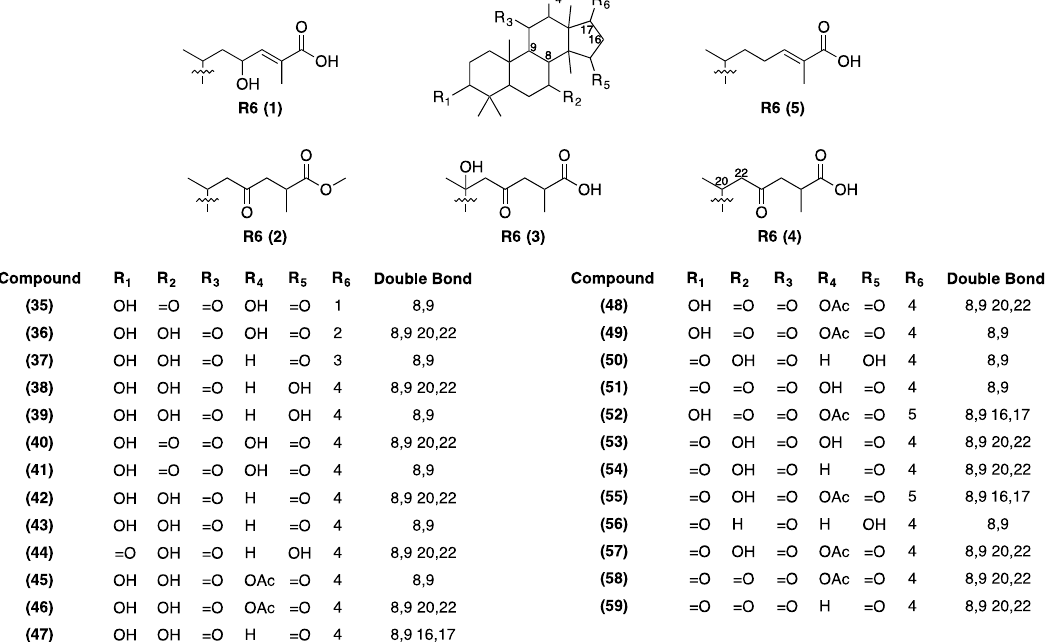
Figure 4. Chemical structures of selected discriminant metabolites from LC/IT-TOF-MS analysis.